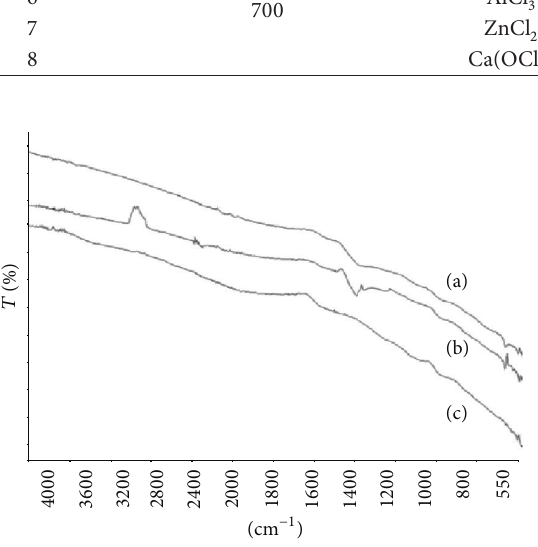
Figure 3: Spectrum of (a) the charcoal sample after pyrolysis at 700 ∘ C, (b) the chemically treated AC followed by pyrolysis at 700 ∘ C, and (c) the Pb(II)-loaded